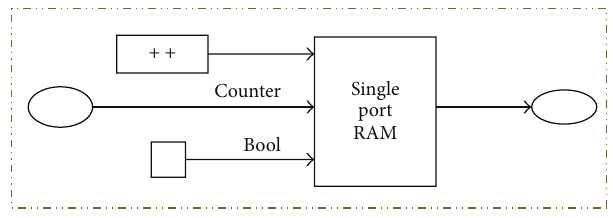
Figure 13: Hardware design within the line buffer shown in Figure